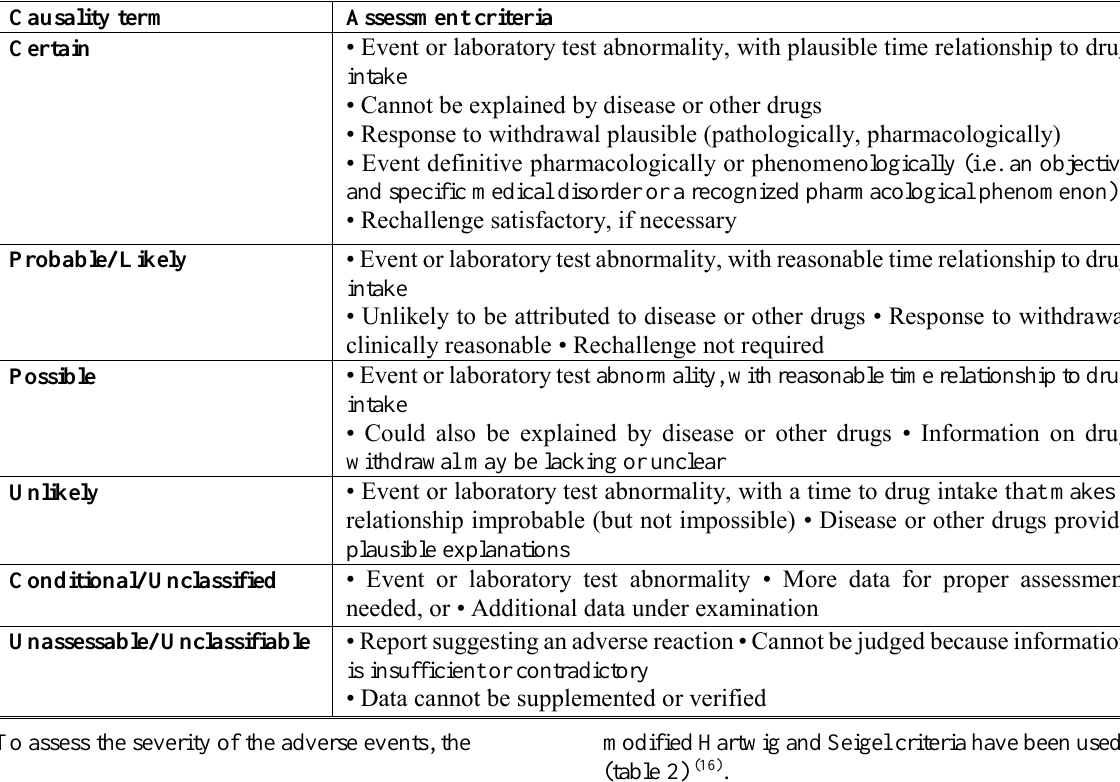
Table 2. Hartwig’s Severity Assessment (16 )